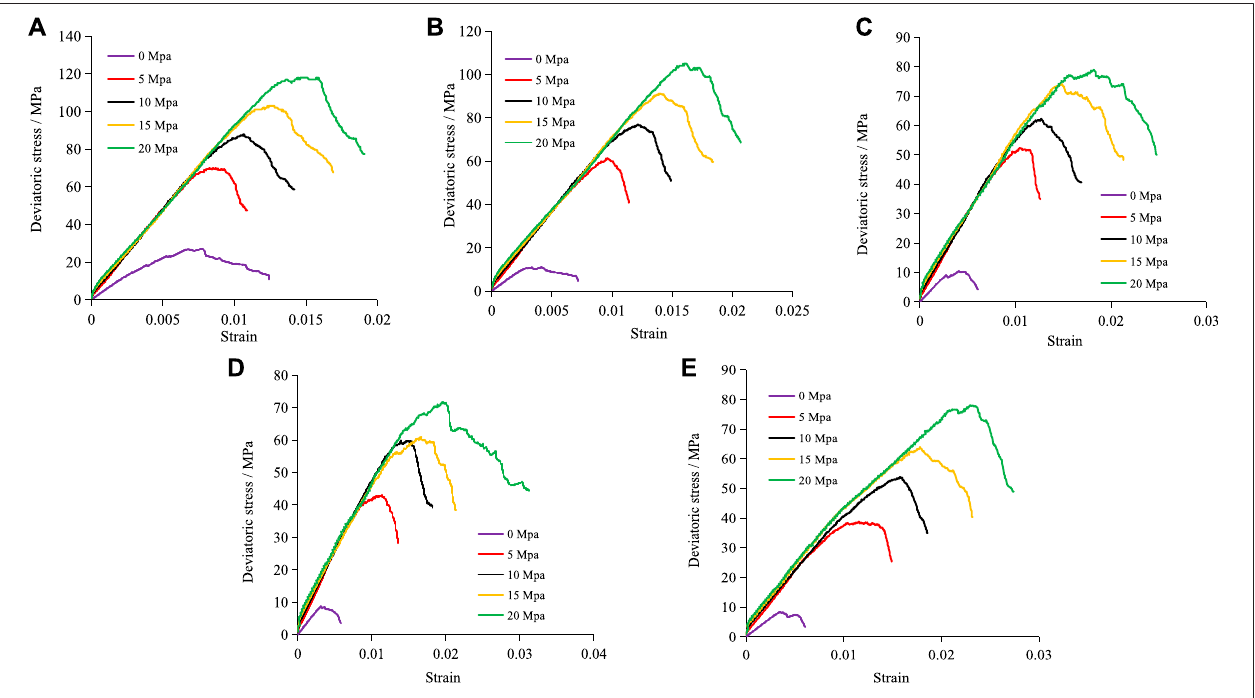
FIGURE 5 | The axial deviatoric stress – strain curves of the RCR composites at different inclined coal seam thicknesses and different con fi ning pressures. (A) Coal thickness 10 mm; (B) Coal thickness 20 mm. (C) Coal thickness 30 mm; (D) Coal thickness 40 mm (E) Coal thickness 50 mm.